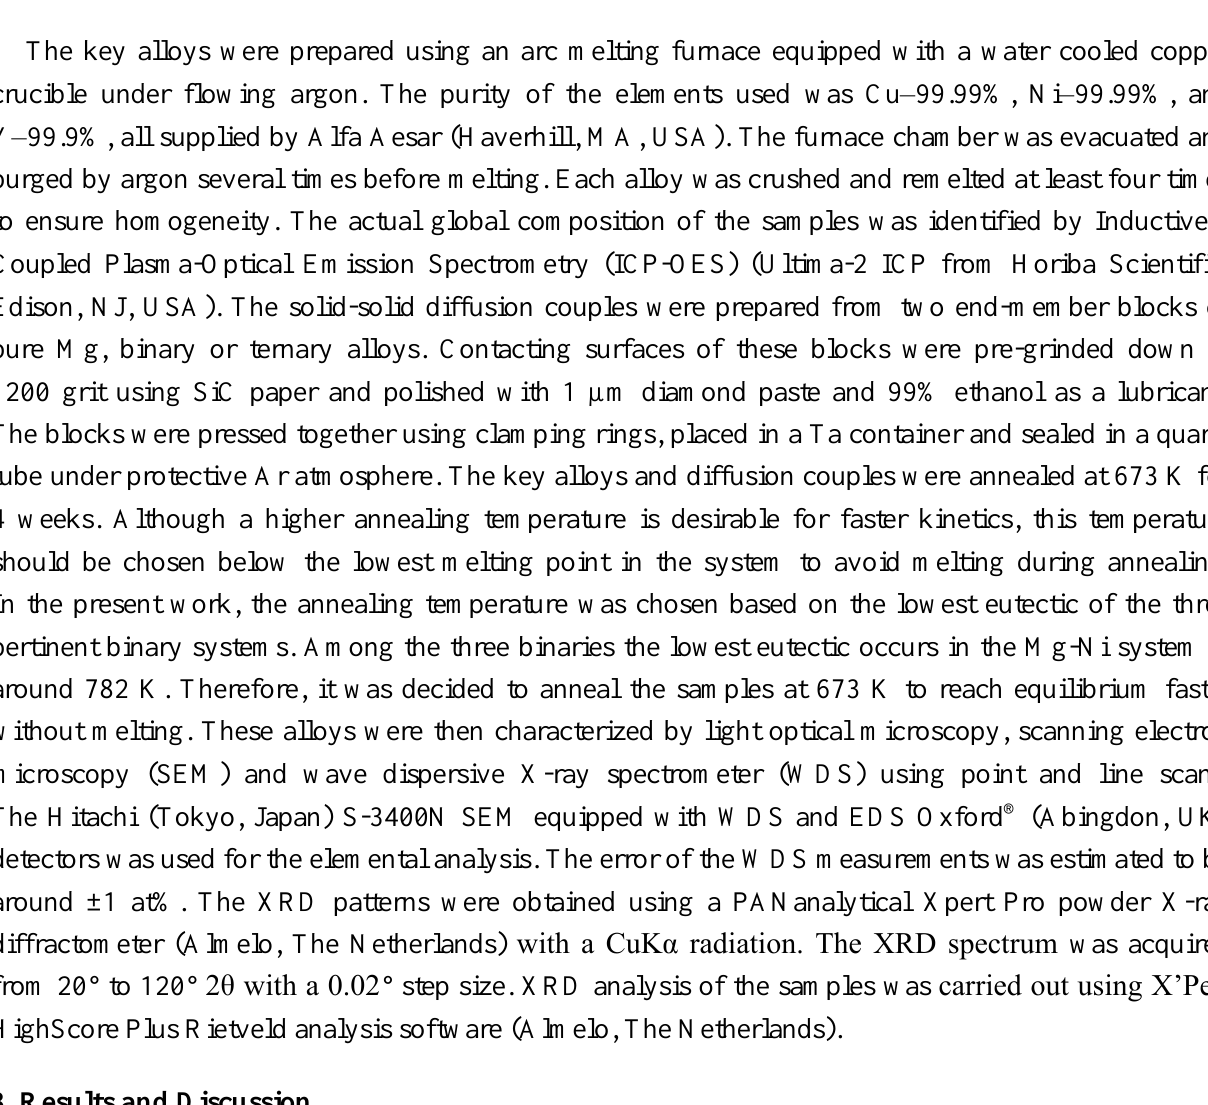
Figure 2. The ternary alloy consists of three phases: NiY, τ 1 (MgNiY 4 ) and τ 5 (Mg 29 Ni 20 Y 42 ). These end members were chosen in order to identify the intermetallic compounds located in the Mg-Y side of the Gibbs triangle. The diffusion couple was annealed for four weeks at 673 K. During the heat treatment, extensive interdiffusion among Mg, Ni, and Y took place allowing various equilibrium phases to form. Each layer represents a phase which is in equilibrium with its adjacent layers. The microstructure of the diffusion couple with increased magnification of the area of interest is shown in Figure 3b. The compositions of the formed phases were detected by the WDS point analysis. The WDS line scans were used to determine the solubility ranges and phase equilibria among the intermetallics. The same approach was used to study other diffusion